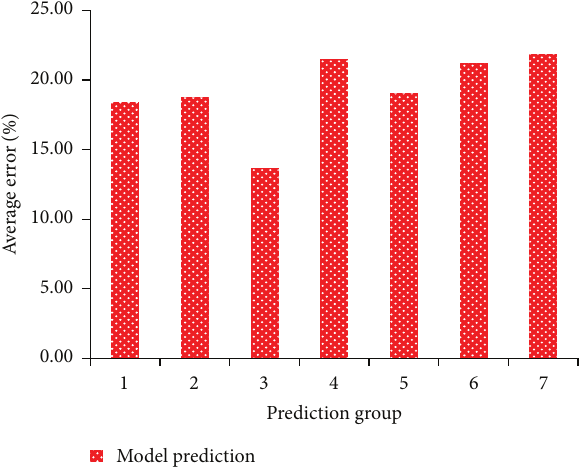
Figure 7: Prediction error of dimension analysis-based